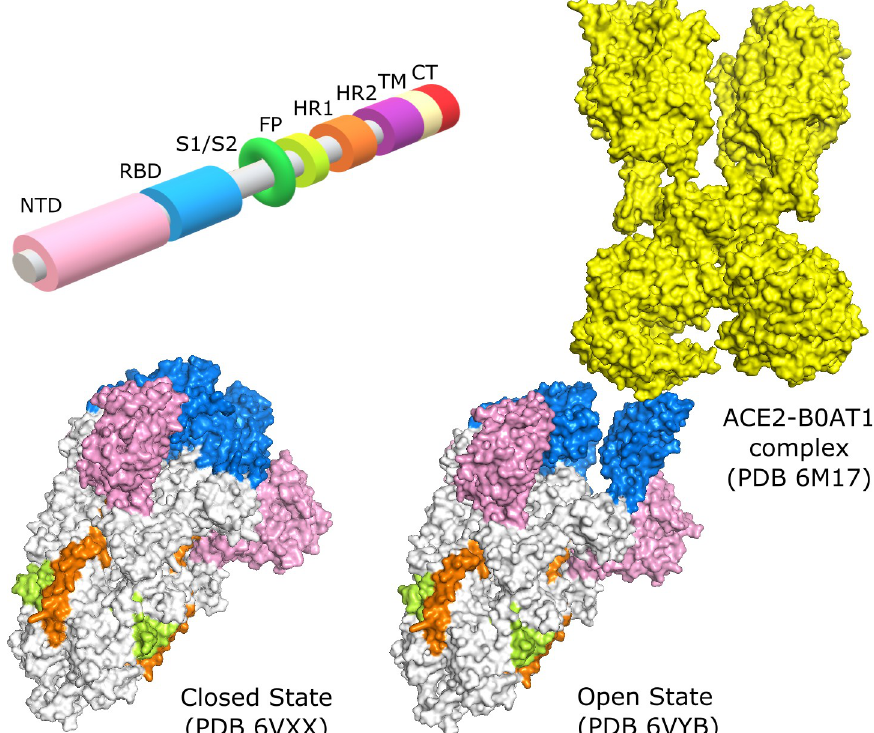
Fig 1. Domains of the Spike protein. N-Terminal Domain (NTD), Receptor Binding Domain (RBD), Subunit 1/ Subunit 2 junction (S1/S2), Fusion Peptide (FP), Heptad Repeat 1 (HR1), Heptad Repeat 2 (HR2), Transmembrane Domain (TM), and the Cytoplasmic Tail (CT). Crystallography structure in the conformational state of all 3 RBD domains closed (PDB 6VXX) and of 1 RBD open (PDB 6VYB), binding to ACE2 (PDB 6M17).